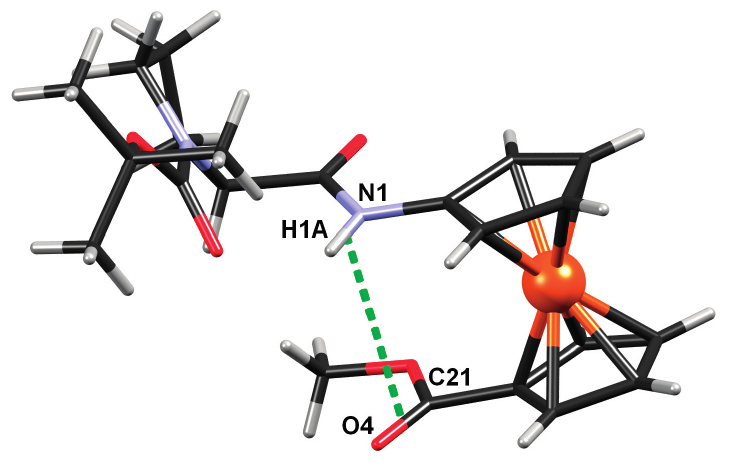
Figure 9. An additional stabilization of Boc-Pro-Fca-OMe ( 3 ) through interchain intramolecular dipolar interaction between CO and NH